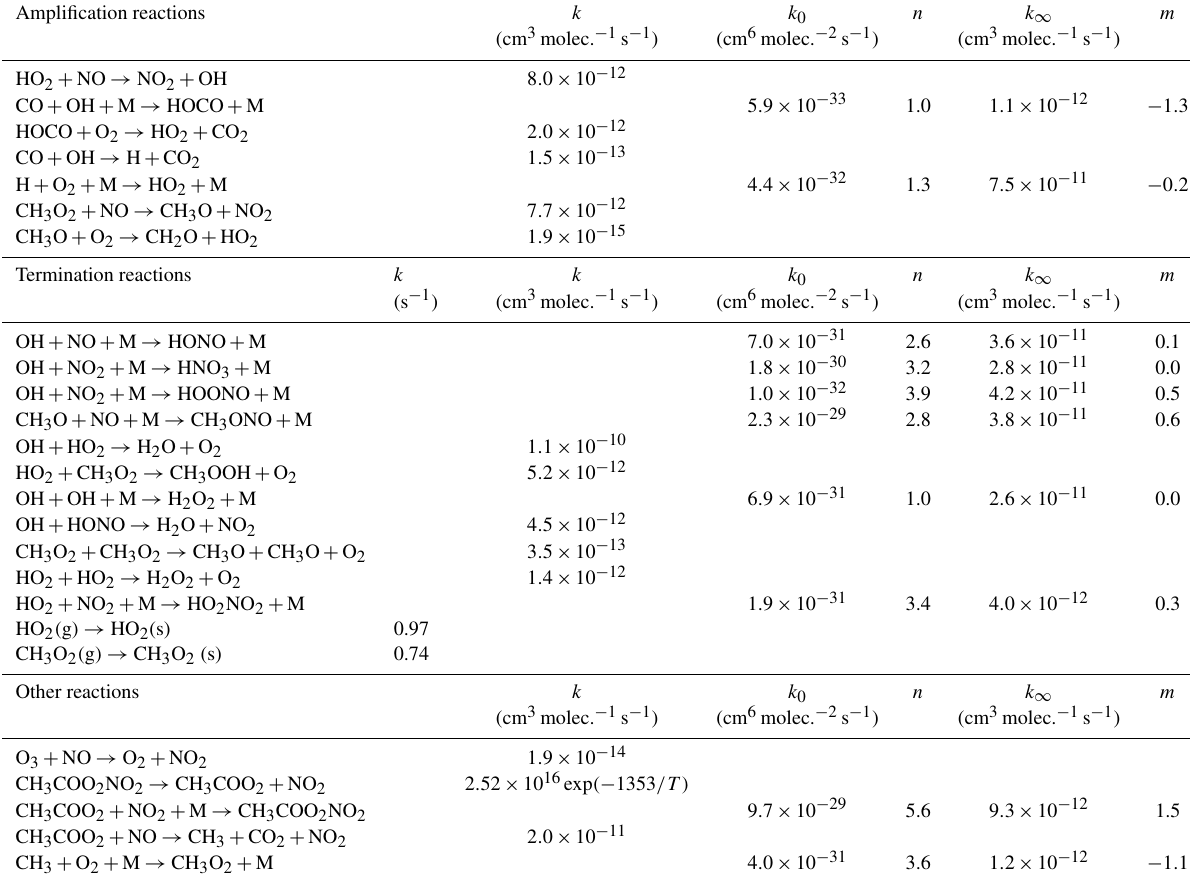
Table 1. Reactions used in a box model for the eCL simulation in the DUALER inlet. Amplification reactions